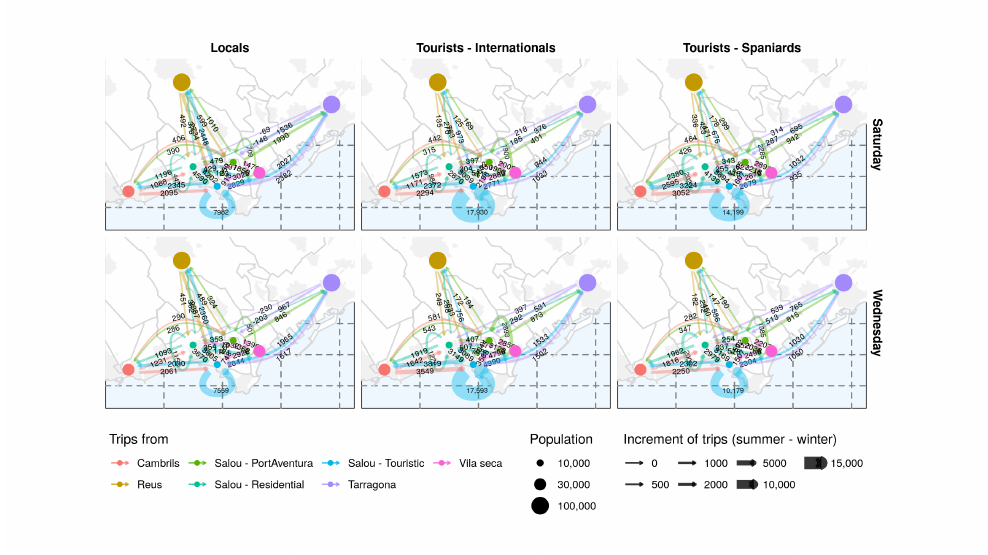
Figure 7. Seasonal increment in the number of trips for local residents, Spanish, and international tourists.